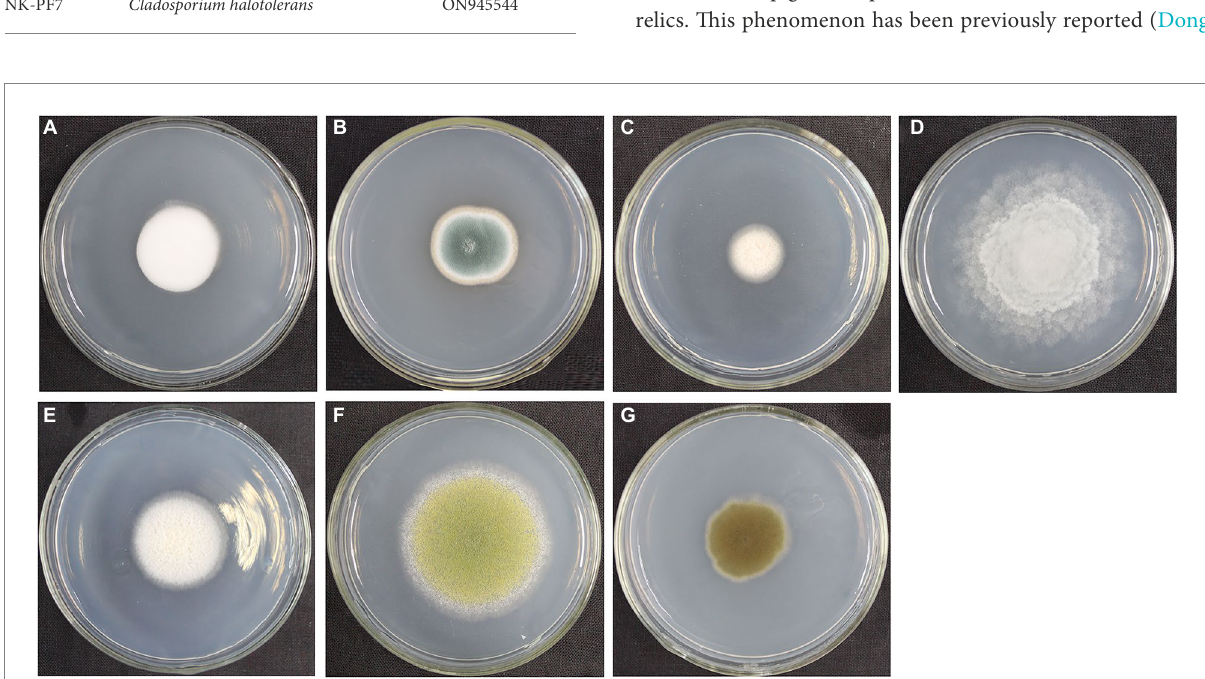
FIGURE 4 Single colony morphology of fungi isolated from the surface of pottery figurines. The fungi were inoculated onto the PDA medium and incubated at 28 ° C for 3 days. (A) Lecanicillium aphanocladii (NK-PF1). (B) Penicillium aurantiogriseum (NK-PF2). (C) Clonostachys rosea (NK-PF3). (D) Mortierella sp. (NK-I). (E) Mortierella alpina (NK-PF5). (F) Aspergillus flavus (NK-PF6). (G) Cladosporium halotolerans